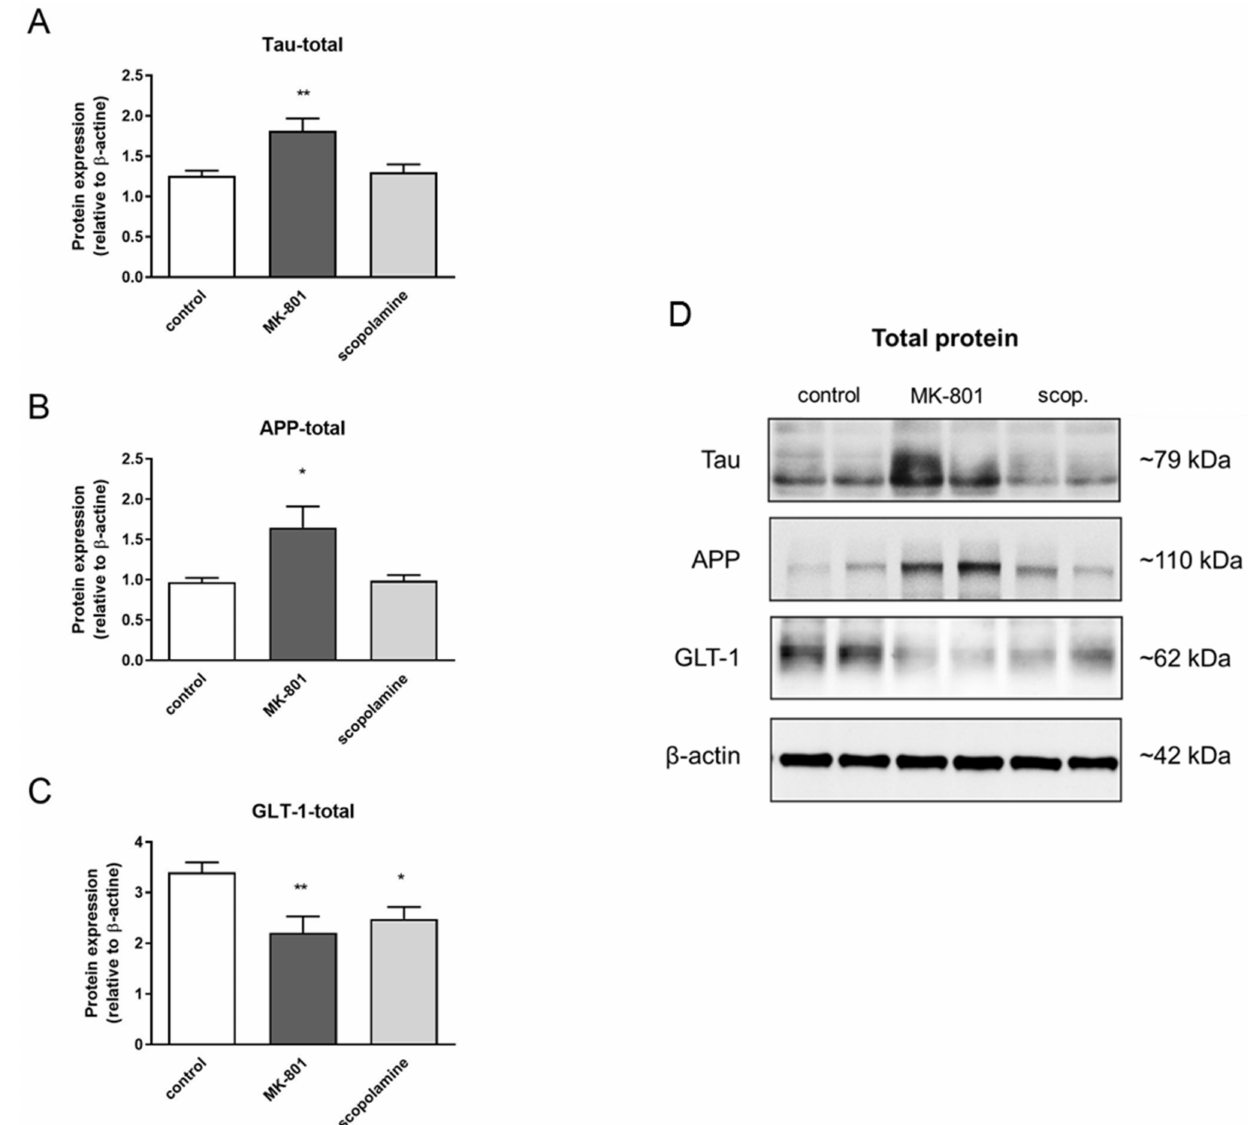
Figure 20. Densitometric analysis of Western blot results demonstrating changes in the expression of Alzheimer precursor protein (APP), tau and glutamate transporter 1 (GLT-1) in the prefrontal cortex after chronic (14 days) administration of MK-801 (0.3 mg/kg) or scopolamine (1 mg/kg) ( A – C ). Expression of total protein was normalized to β -actin. Representative Western blots ( D ). Data are presented as means ± SEM. * p < 0.05; ** p < 0.01 compared to the untreated control group. Comparison between the total expression of tau or APP protein and their S-nitrosylated forms showed very similar patterns (F (2.24) = 4.95, p < 0.001; F (2.23) = 4.45, p < 0.02, respec- tively) (Figure 21A,B). Chronic administration of MK-801 and scopolamine significantly upregulated the S-nitrosylation of GLT-1 compared to the control group (F (2.23) = 6.65, p < 0.005) (Figure